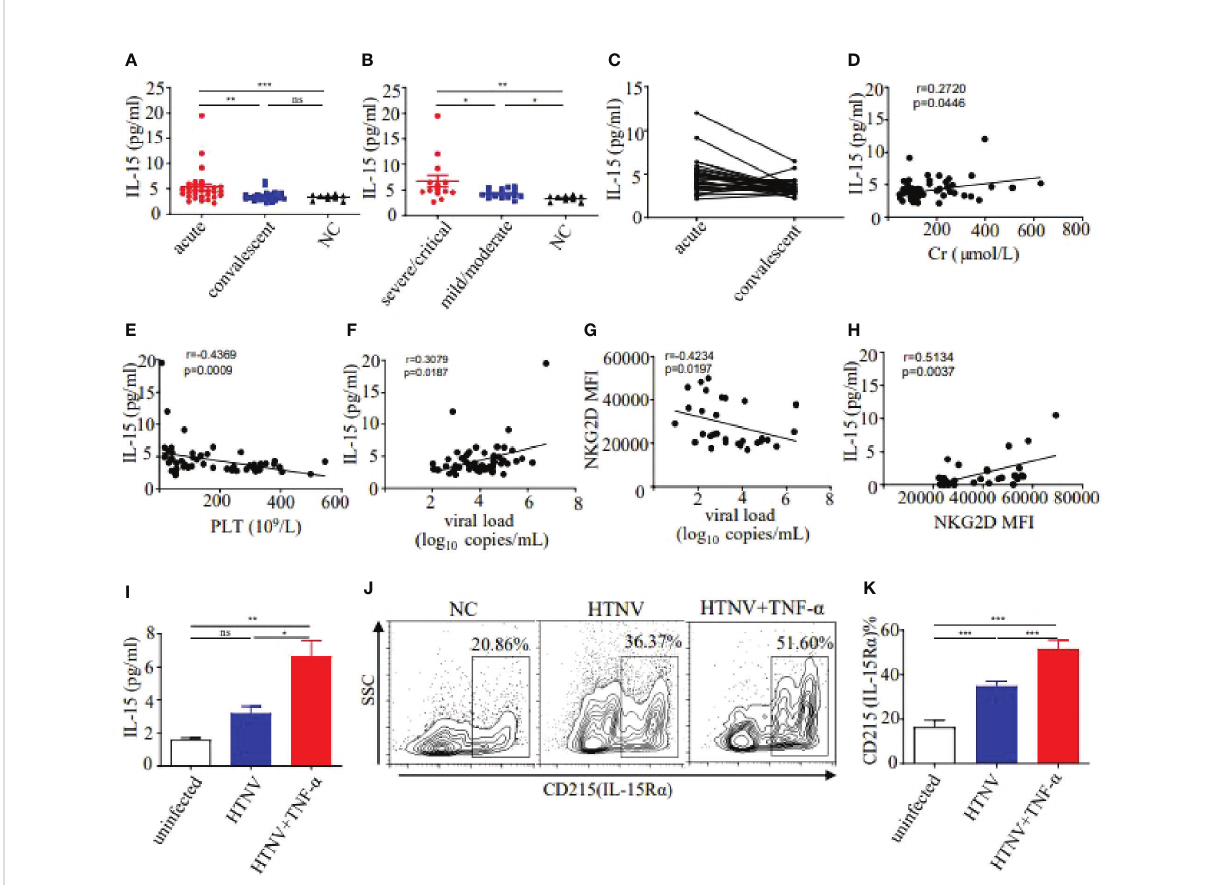
FIGURE 3 Detection of IL-15 levels in plasma and supernatant, and expression of IL-15R a on HUVECs. (A) Comparison of the plasma IL-15 levels between acute (n=30) and convalescent phase (n=28) in HFRS patients. (B) Comparison of the plasma IL-15 levels in different severities of HFRS patients (both n=14). (C) The tendency in the plasma IL-15 levels from the acute to convalescent phases in HFRS patients (n=28). (D, E) Correlations between the plasma IL-15 levels and Cr levels (n=55) or PLT counts (n=55). (F, G) Correlations between the plasma HTNV RNA loads and plasma IL-15 levels (n=58) or NKG2D MFI (n=30). (H) Correlations between the plasma IL-15 levels and MFI of NKG2D on CD38 + HLA-DR + CD8 + T cells in HFRS patients (n=30). (I) Comparison of the IL-15 levels in supernatant of HUVECs infected with HTNV (n=3), HTNV and TNF- a (n=3),